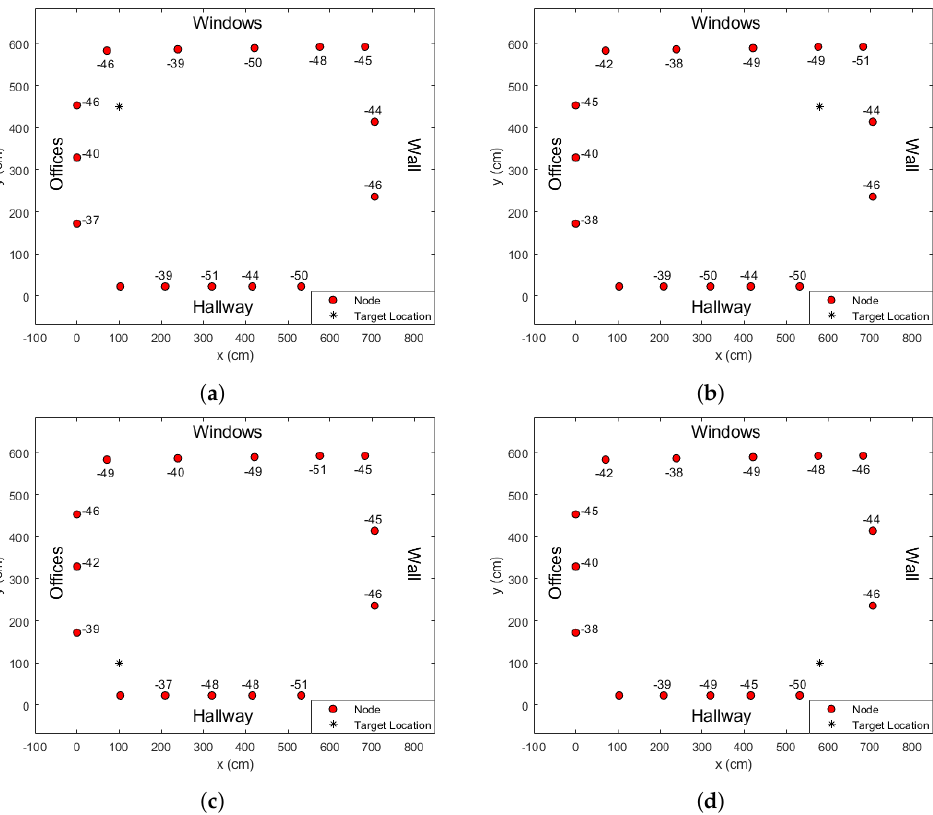
Figure 4. Average Received Signal Strength (RSS) values with which communication between node 1 and every other node occurs, for four different locations at which a target could be present. The target is present near the upper left corner of the environment in ( a ), the upper right corner in ( b ), the lower left corner in ( c ) and the lower right corner in ( d ). All RSS values are in dBm. Table 2. An overview of the most important experiment parameters. Transmission power refers to the output power as configured in the